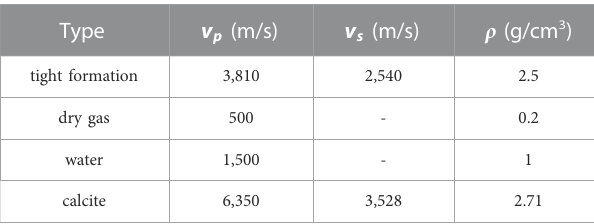
TABLE 1 Physical parameters of elastic formation and fracture fi lling